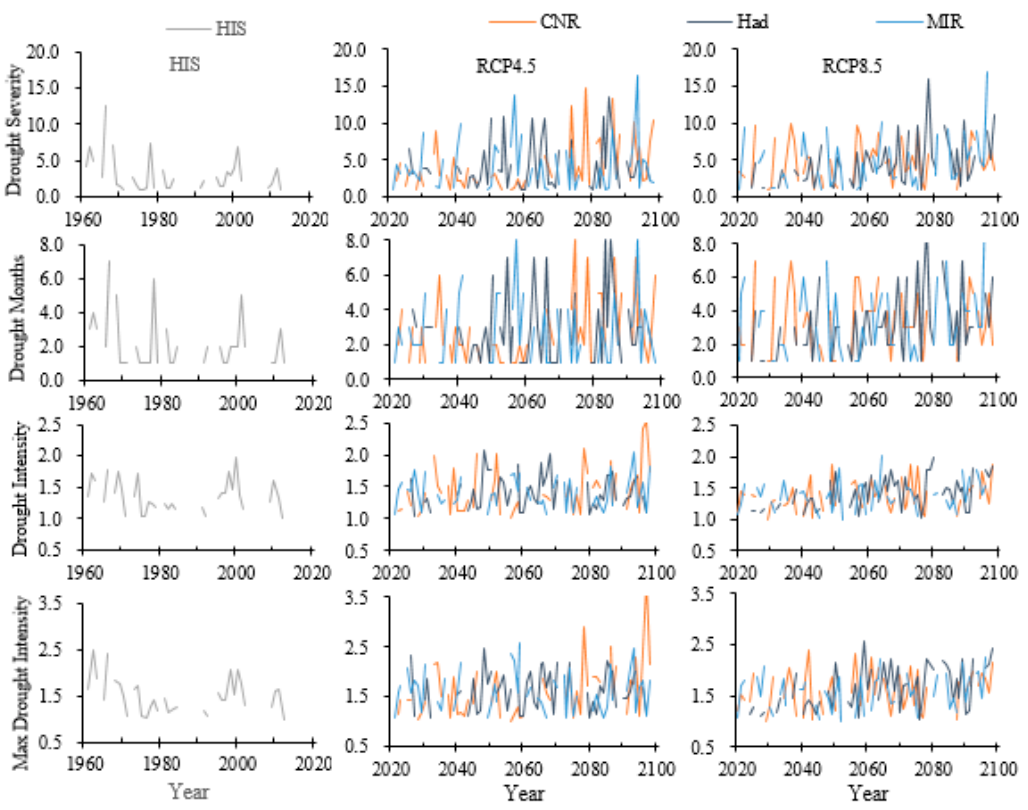
Figure 8. Changes of annual drought characteristic values historically (1961–2015) and in the future (2020–2098). Table 8. The linear slope of annual drought characteristic values historically and in the future.